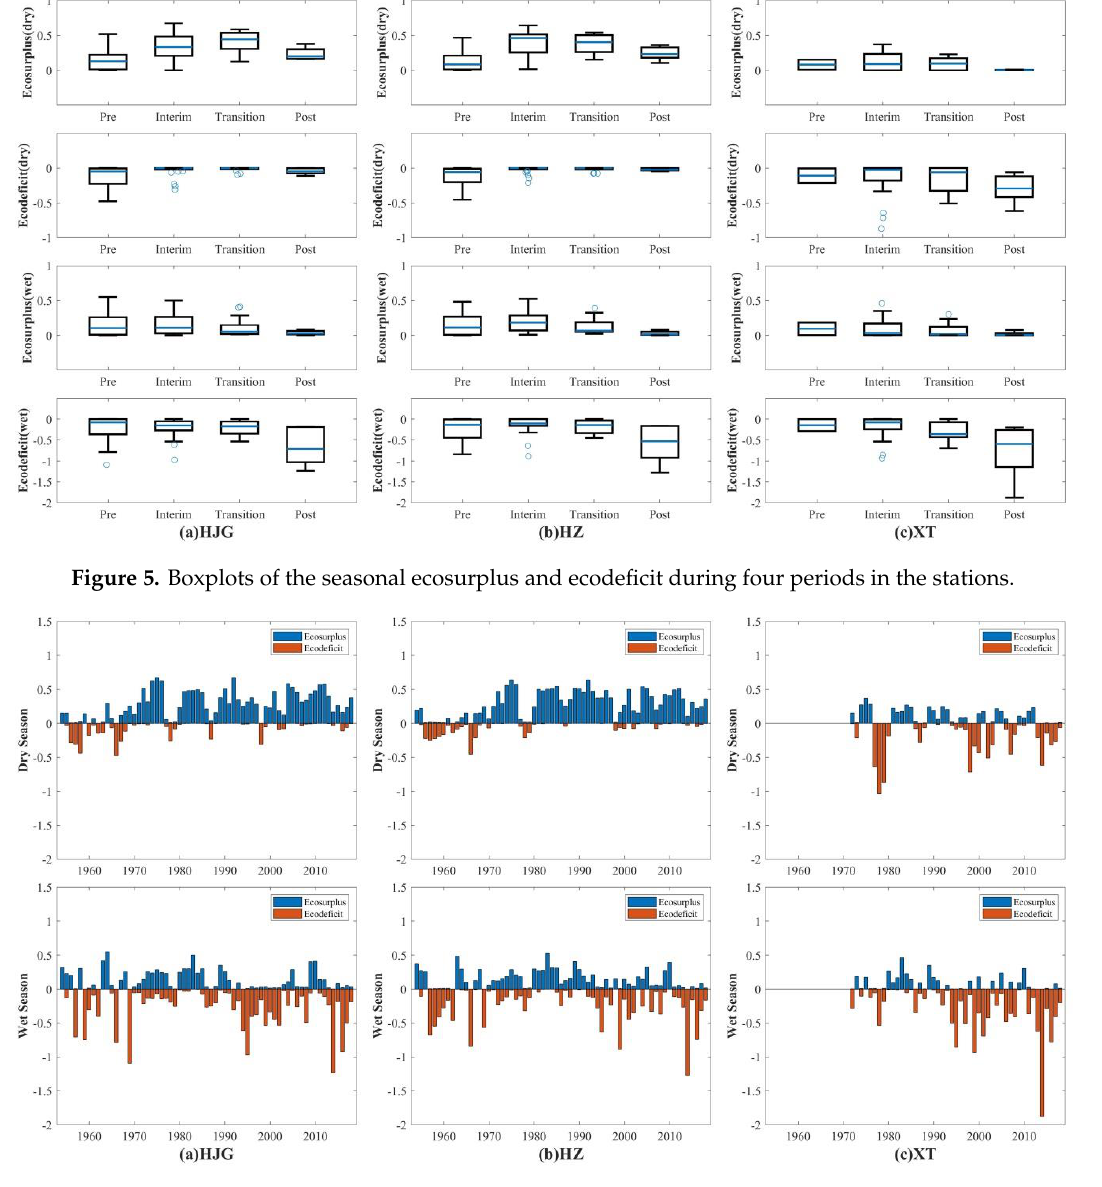
Figure 6. Changes of seasonal ecosurplus and ecodeficit in the stations.